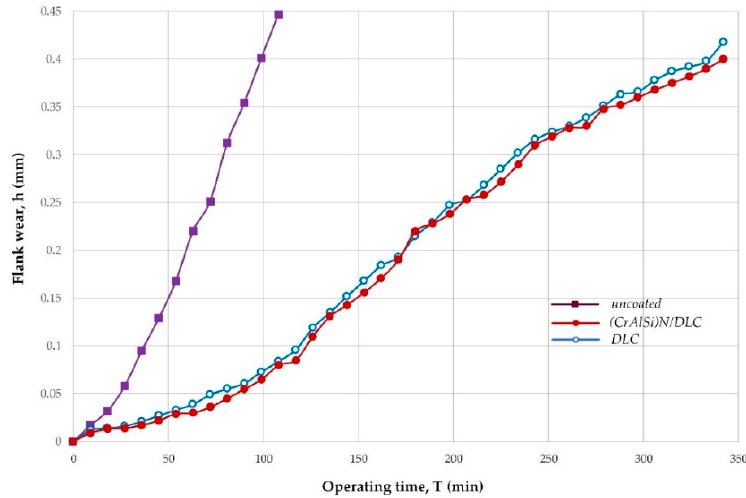
Figure 10. Dependence of the wear chamfer size on the flank surface of the end mills on the operating time when machining the aluminum alloy AlCuMg2 with end mills with different coatings.